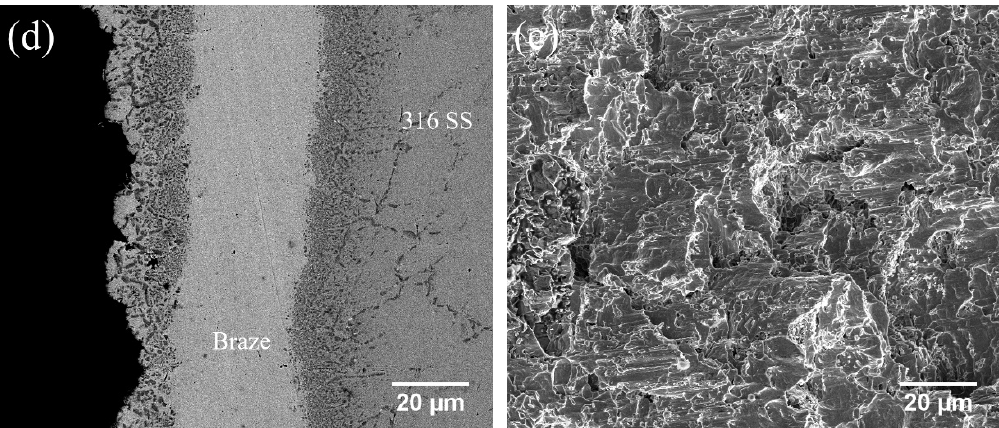
Figure 9. SEM ( a ) cross-section, ( b ) fractograph and ( c ) XRD pattern of CoCrFeMnNi / BNi-2 / 316 SS joint infrared brazed at 1020 ◦ C for 600 s; ( d ) cross-section and ( e ) fractograph of CoCrFeMnNi / BNi-2 / 316 SS joint infrared brazed at 1050 ◦ C for 600 s.